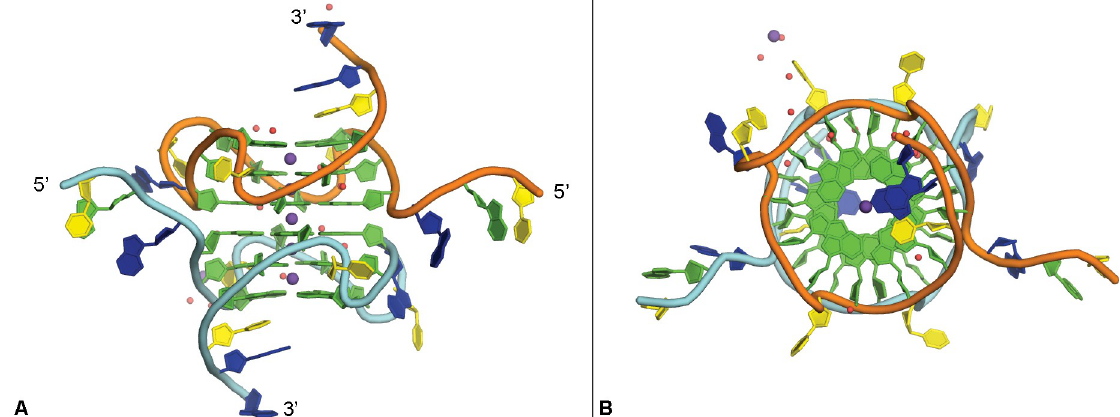
Fig 2. Crystal structure of c-MYC quadruplex. Side-view (A) and top-view (B) of the crystal structure of the c-MYC promoter quadruplex formed by Pu22, guanine bases in green, thymine in yellow, adenine in blue. Potassium ions in purple (two shown positioned behind strand backbones), waters in red. Orange/cyan backbone coloring represents strand A and B,